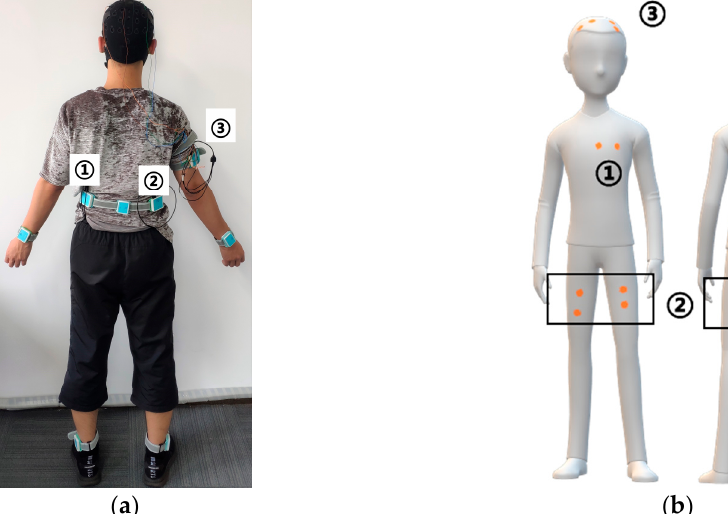
Figure 5. ( a ) Placement of the eight sensors; the numbers identify the three electrophysiological sensors. ( b ) Diagram of the electrode placement position of the electrophysiological sensors.